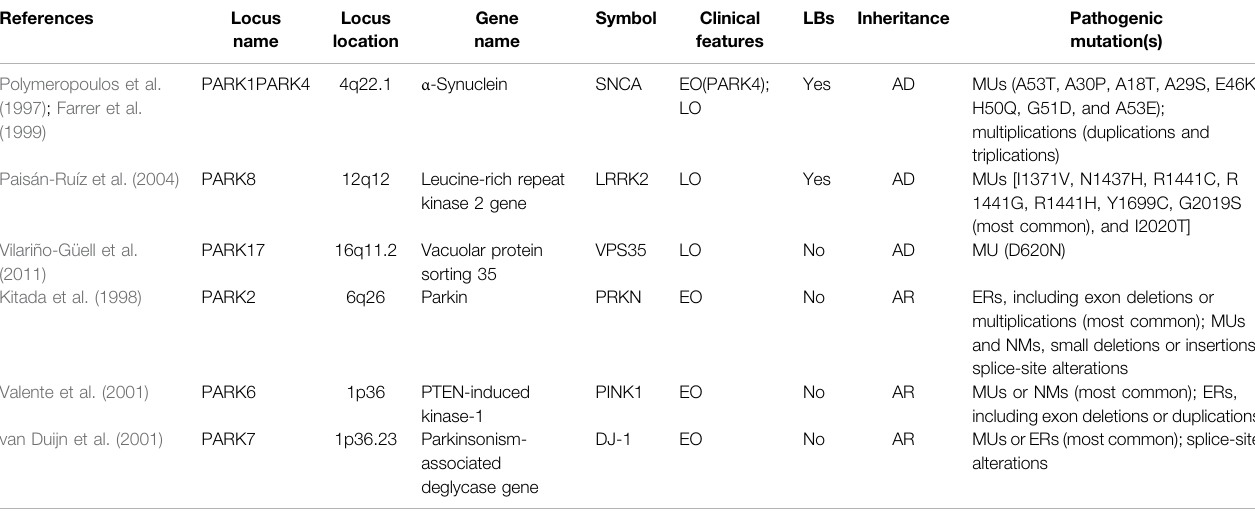
TABLE 1 | Common monogenic forms of Parkinson ’ s disease-causing locus and